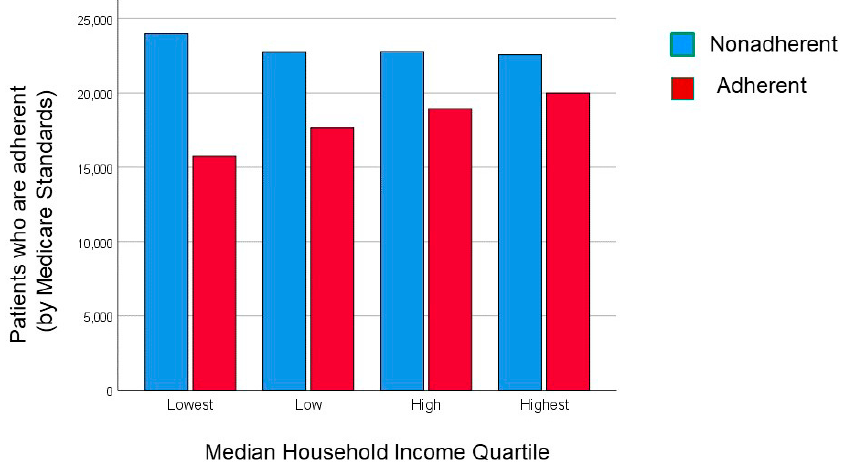
Figure 2. Number of patients who are adherent (red column) or nonadherent (blue columns) to positive airway pressure therapy by Medicare standards are shown by median household income quartile ranging from the lowest to the highest income levels. Note that the number of patients who are PAP adherent progressively increases as the median household income increases ( χ 2 < 0.0001). In our